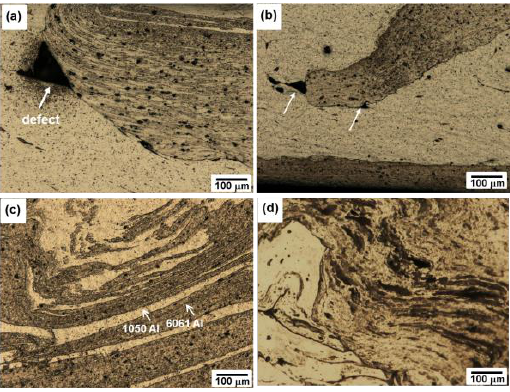
Figure 5. OM images showing the microstructure of the stir zone of the dissimilar FSW joints obtained at the different revolutionary pitches of ( a ) 1.25; ( b ) 1; ( c ) 0.75; and ( d ) 0.5 mm/rev.